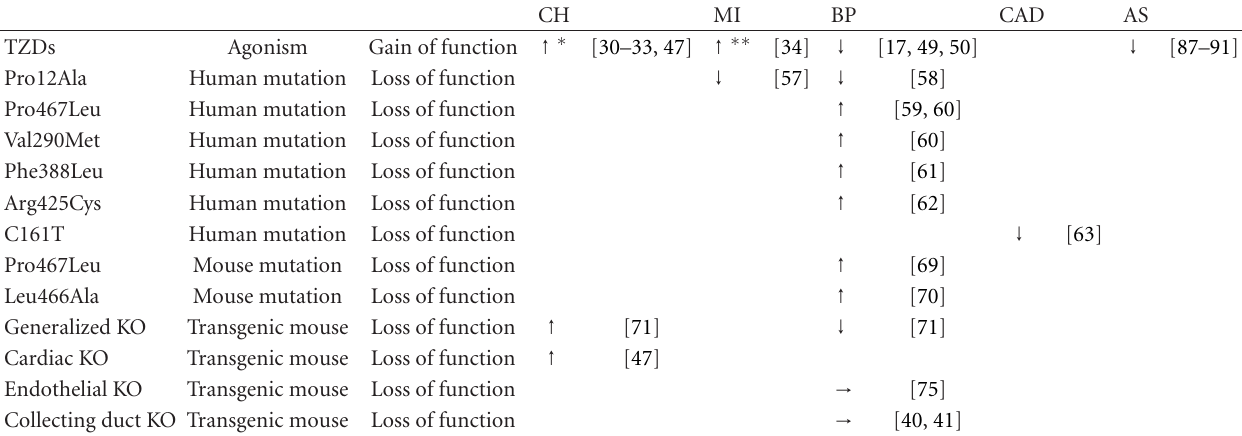
Table 1: Cardiovascular phenotypes in gain and loss of PPAR- γ